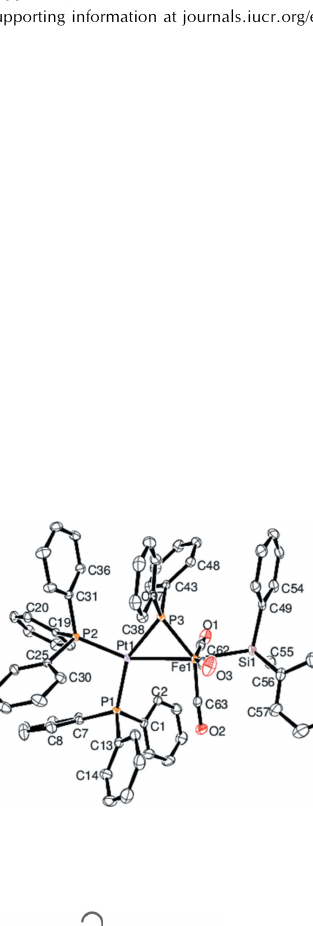
Figure 1 The reaction scheme for the synthesis of